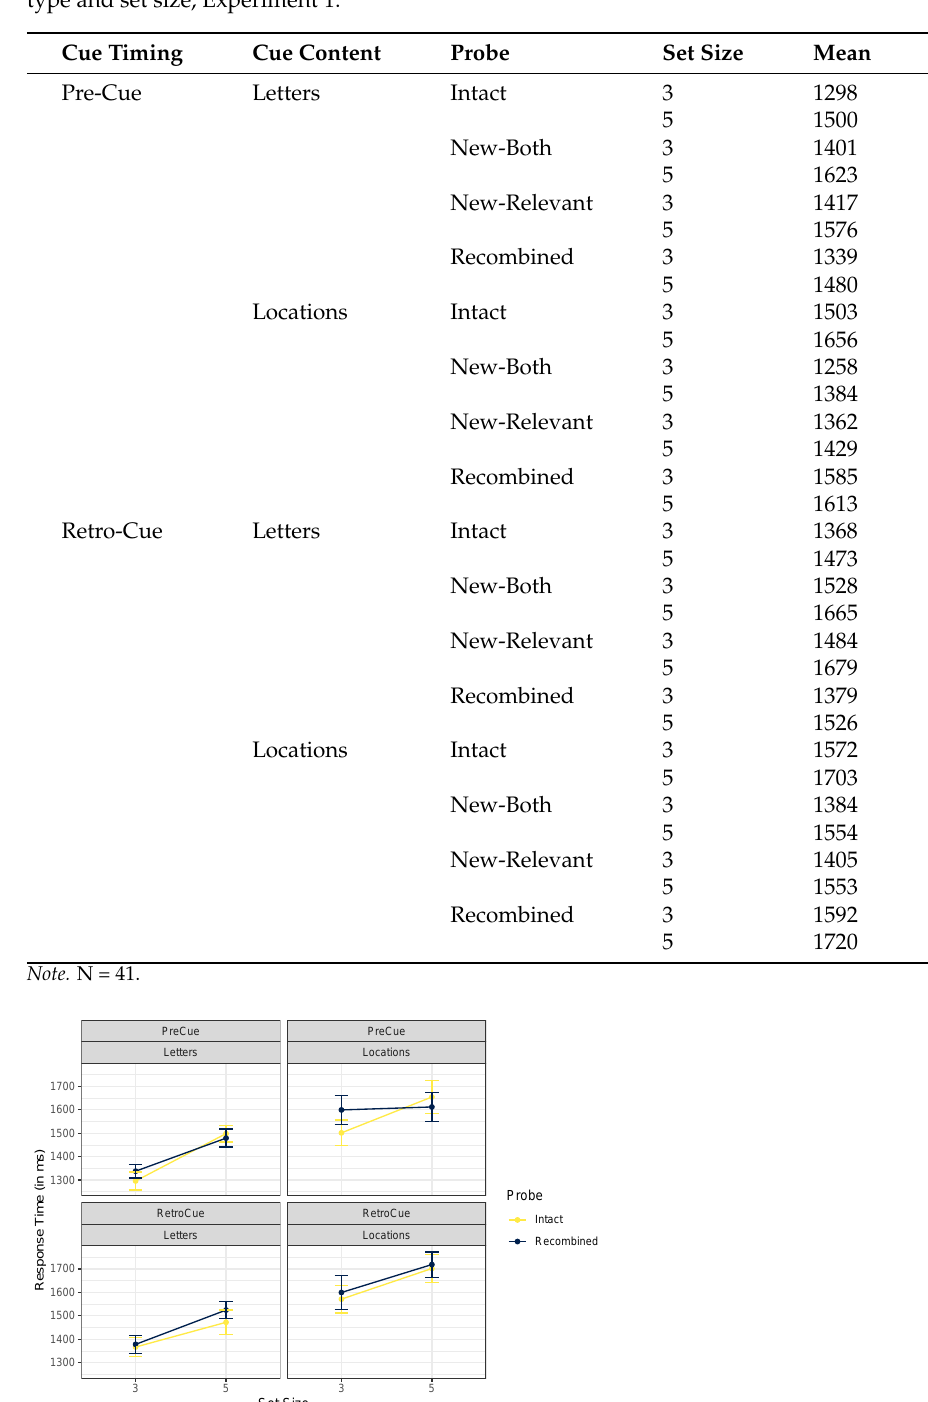
Table 2. Mean trimmed response times (with standard deviations) per cue timing, cue content, probe type and set size, Experiment 1.